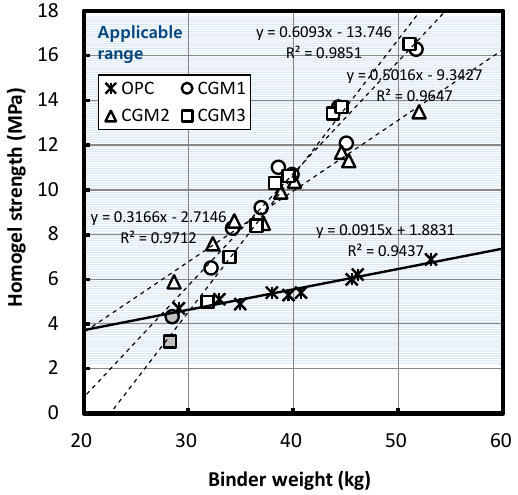
Figure 9. Homogel strength by binder weight.